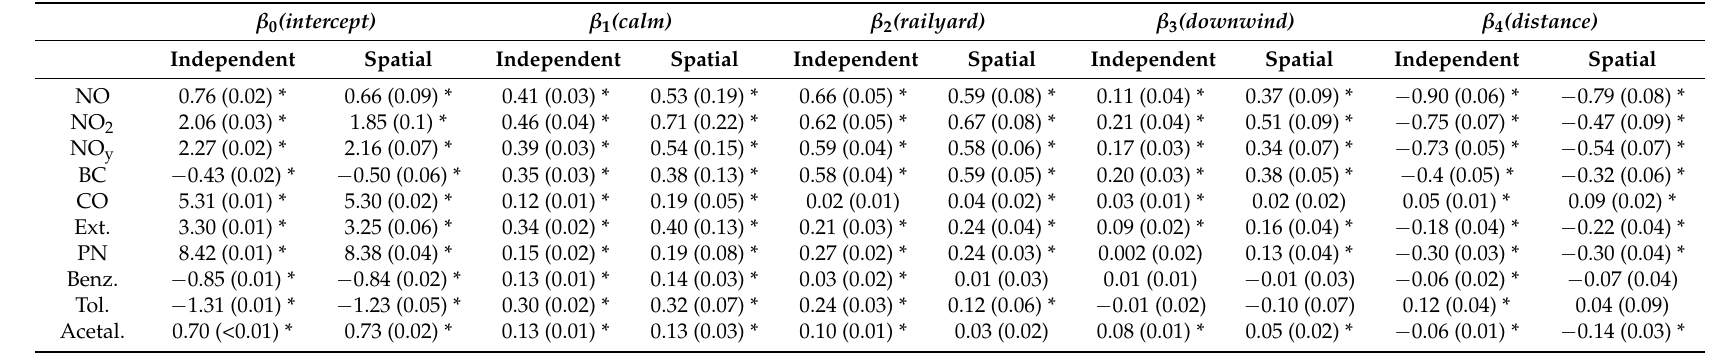
Table 3. Regression Results. Estimated effect of each of the predictors on the mean log transformed pollutant concentration, using both the independent and spatially correlated error models. Standard errors of the estimates are shown in parenthesis. Estimates that are significantly different from 0 ( p -value less than 0.05) are marked with